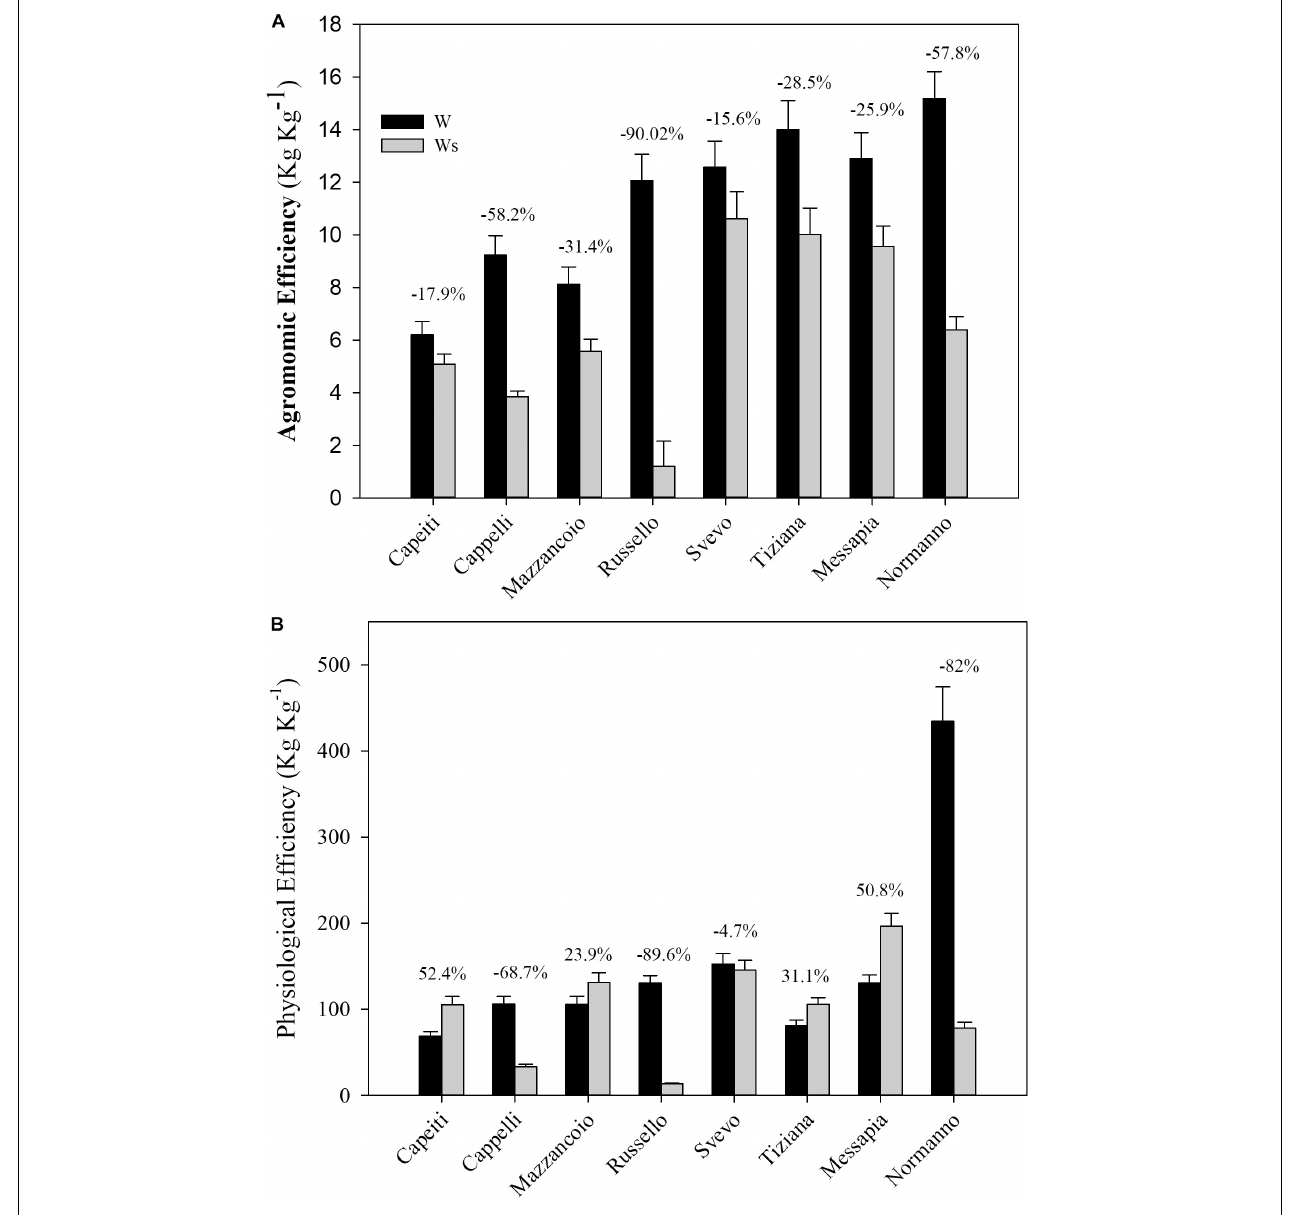
FIGURE 2 | Agronomic (A) and physiological (B) efficiency of eight durum wheat genotypes exposed to two water regimes in the field. Values are means ( n = 5) ± SE.